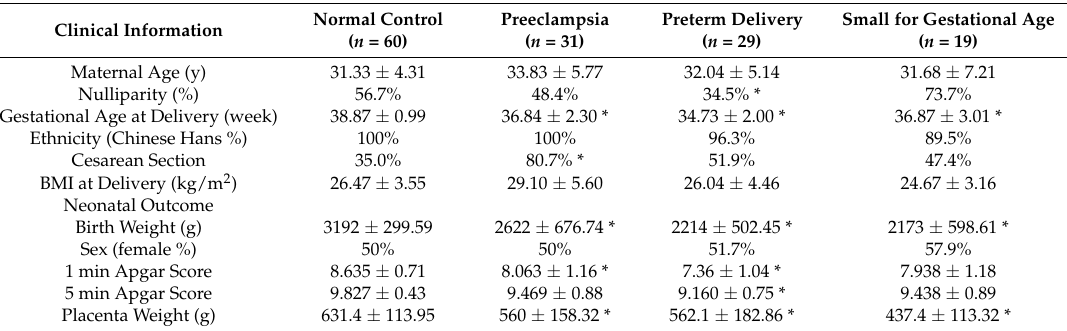
Table 1. Characteristics of included study